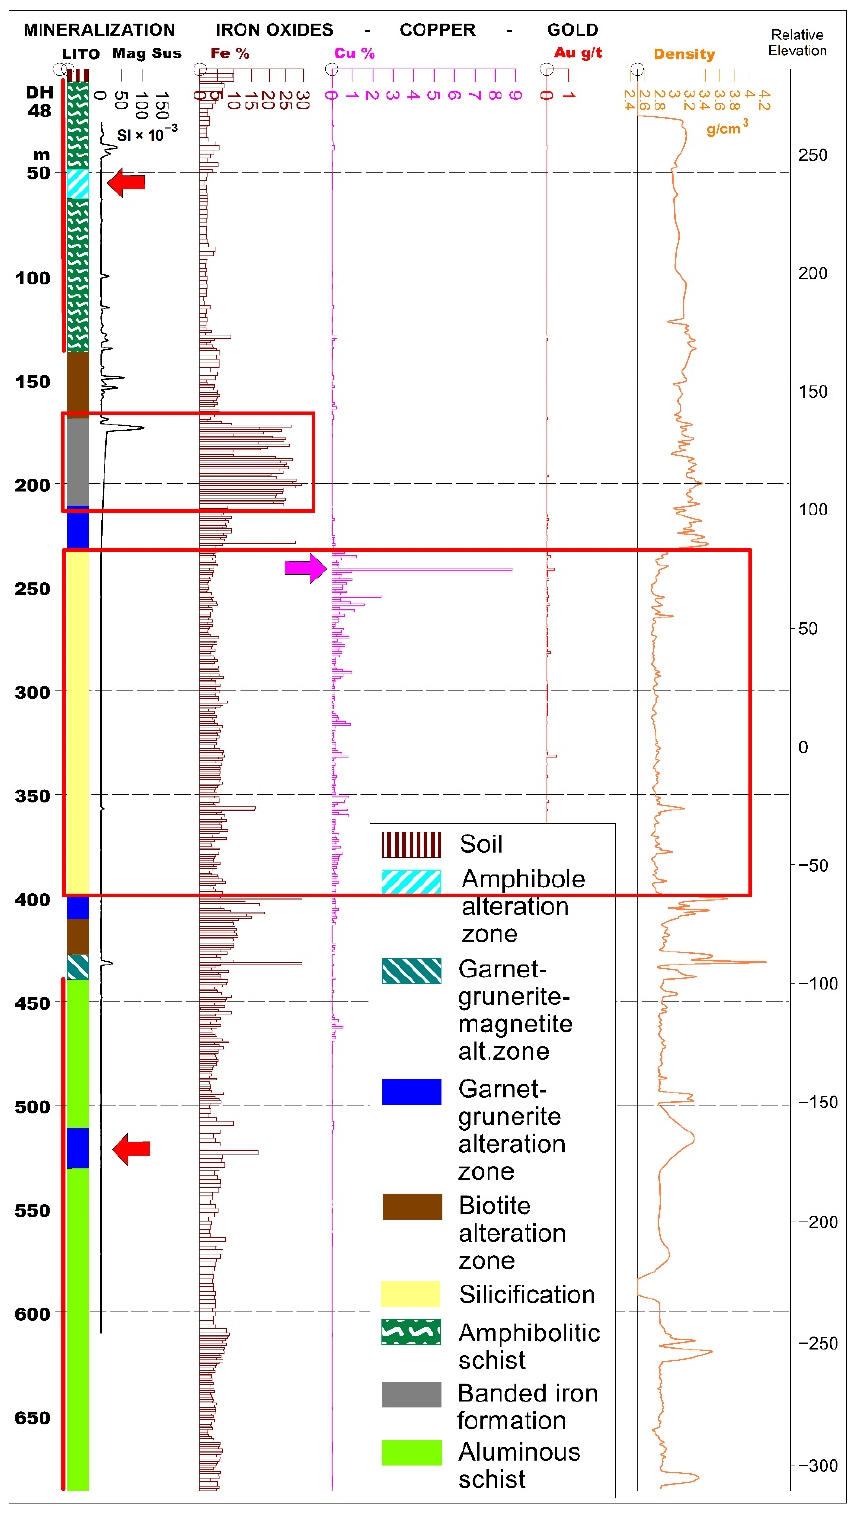
Figure 11. Sampling on the drill hole 48 log with the amphibolitic schist on top and an aluminous schist at the base (red bars) hosting the mineralized zone. Small red box: 169 m to 211 m depth, banded iron formation footprints with low magnetic susceptibility and high iron grade. Big red box: 230 m to 400 m depth, mineralized zone dominated by silicification. Red arrows: Non-magnetic hydrothermal alteration zones cutting host rocks. Magenta arrow: High-grade (9% copper) silicification vein type mineralization. No positive gold assay values were obtained below the legend.